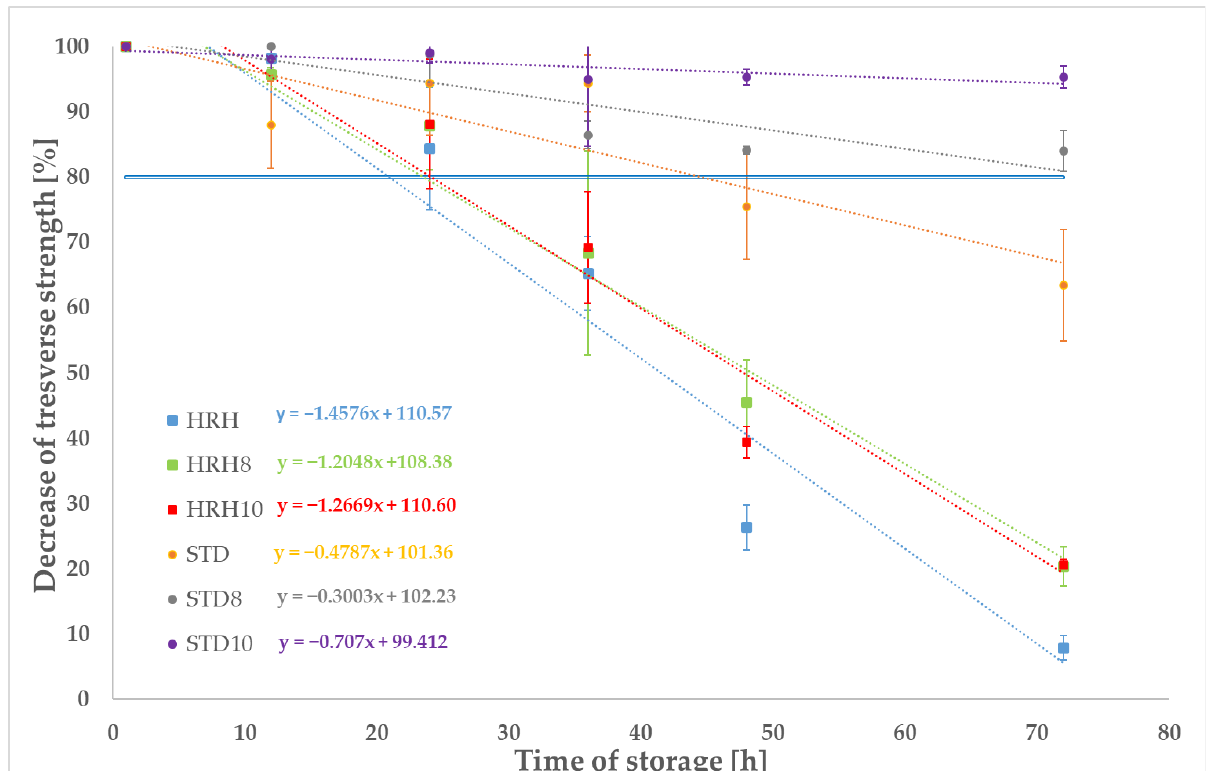
Figure 4. Decrease of transverse strength (in %) depending on the time of storage under different storage conditions (different shooting pressures used within the core production), average values calculated from three measurements are captured, error bars represent the standard deviation: HRH—High relative humidity, constant temperature—RH = 90% ± 5%, t = 25 °C, Shooting pressure 6 bar; HRH8—High relative humidity, constant temperature—RH = 90% ± 5%, t = 25 °C, Shooting pressure 8 bar; HRH10—High relative humidity, constant temperature—RH = 90% ± 5%, t = 25 °C, Shooting pressure 10 bar; STD—Laboratory ambient conditions—RH = 60% ± 5%, t = 25 °C, Shooting pressure 6 bar; STD8—Laboratory ambient conditions—RH = 60% ± 5%, t = 25 °C, Shooting pressure 8 bar; STD10—Laboratory ambient conditions—RH = 60% ± 5%, t = 25 °C, Shooting pressure 10 bar.